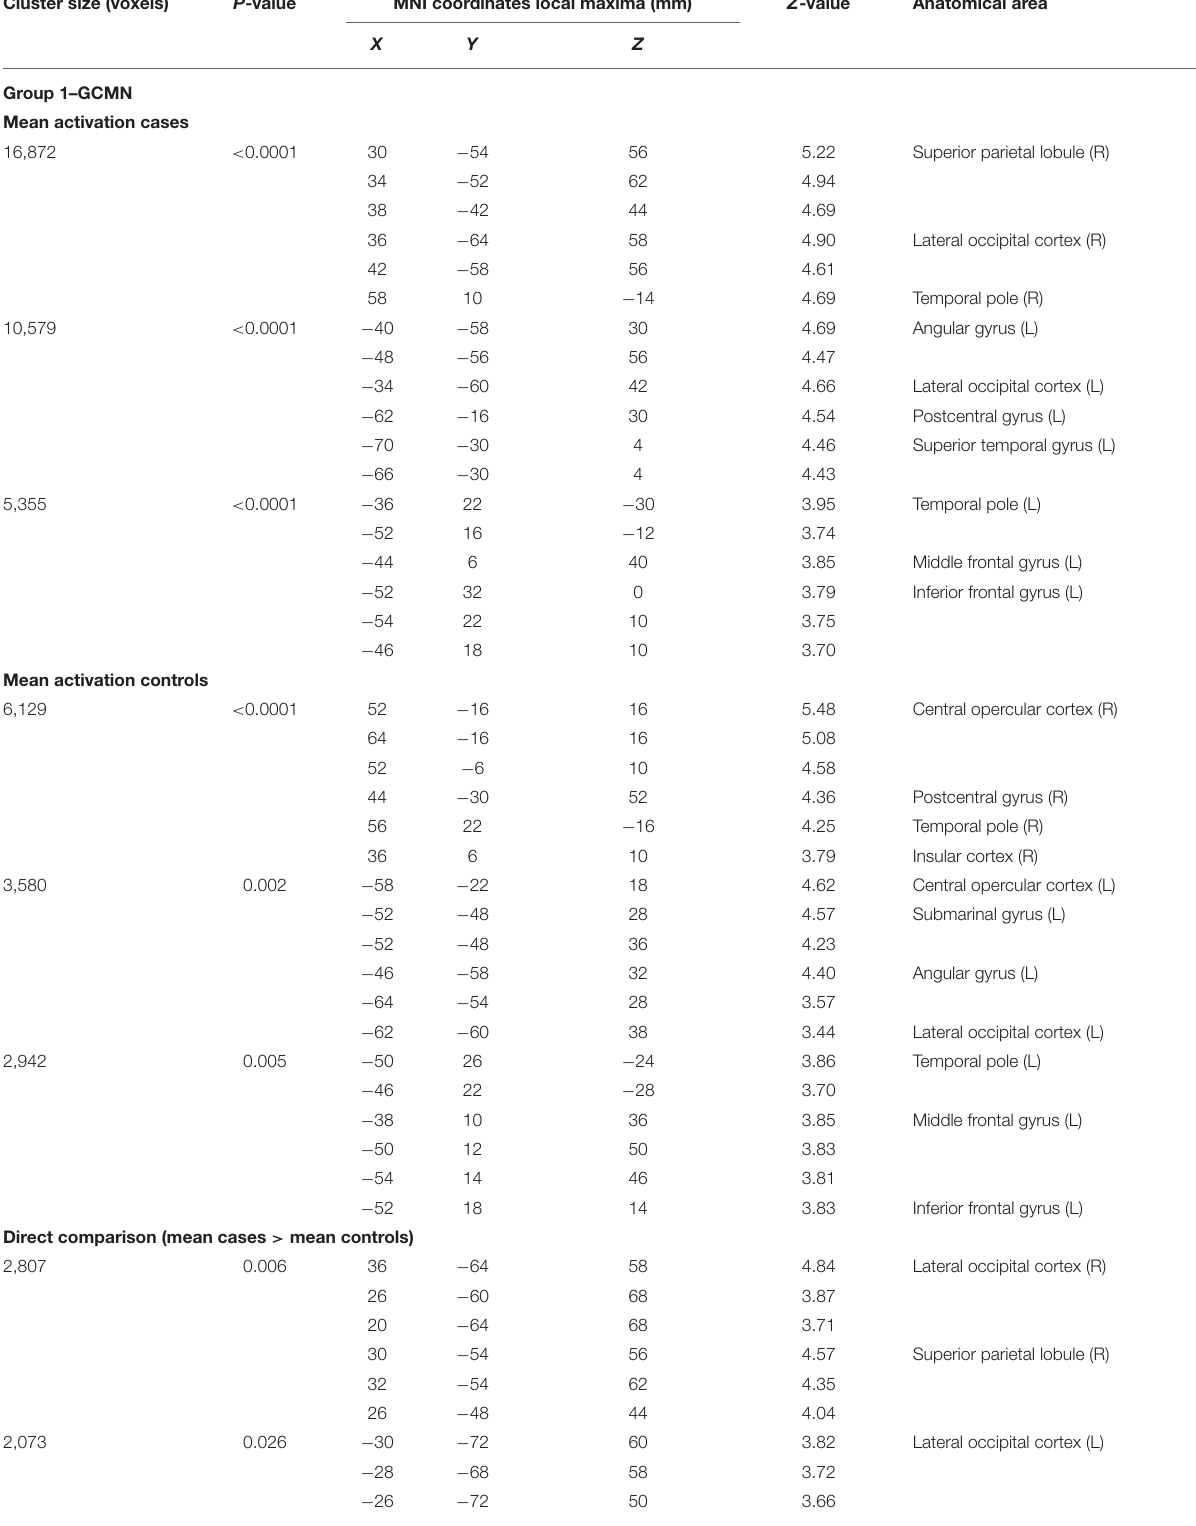
TABLE 5 | Areas of activation during